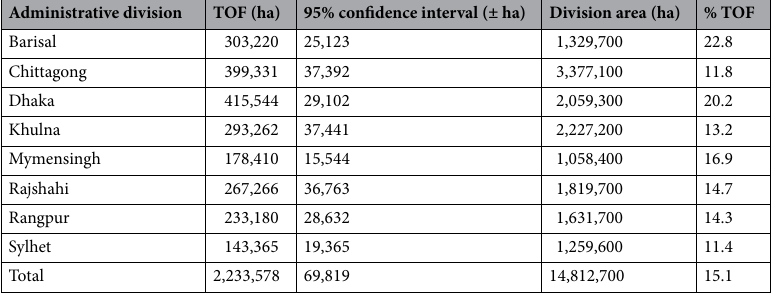
Table 1. TOF area within the divisions of Bangladesh. Associated with each division is the 95% confidence interval on the mapped area and the total proportion of area that TOF occupies in each division.